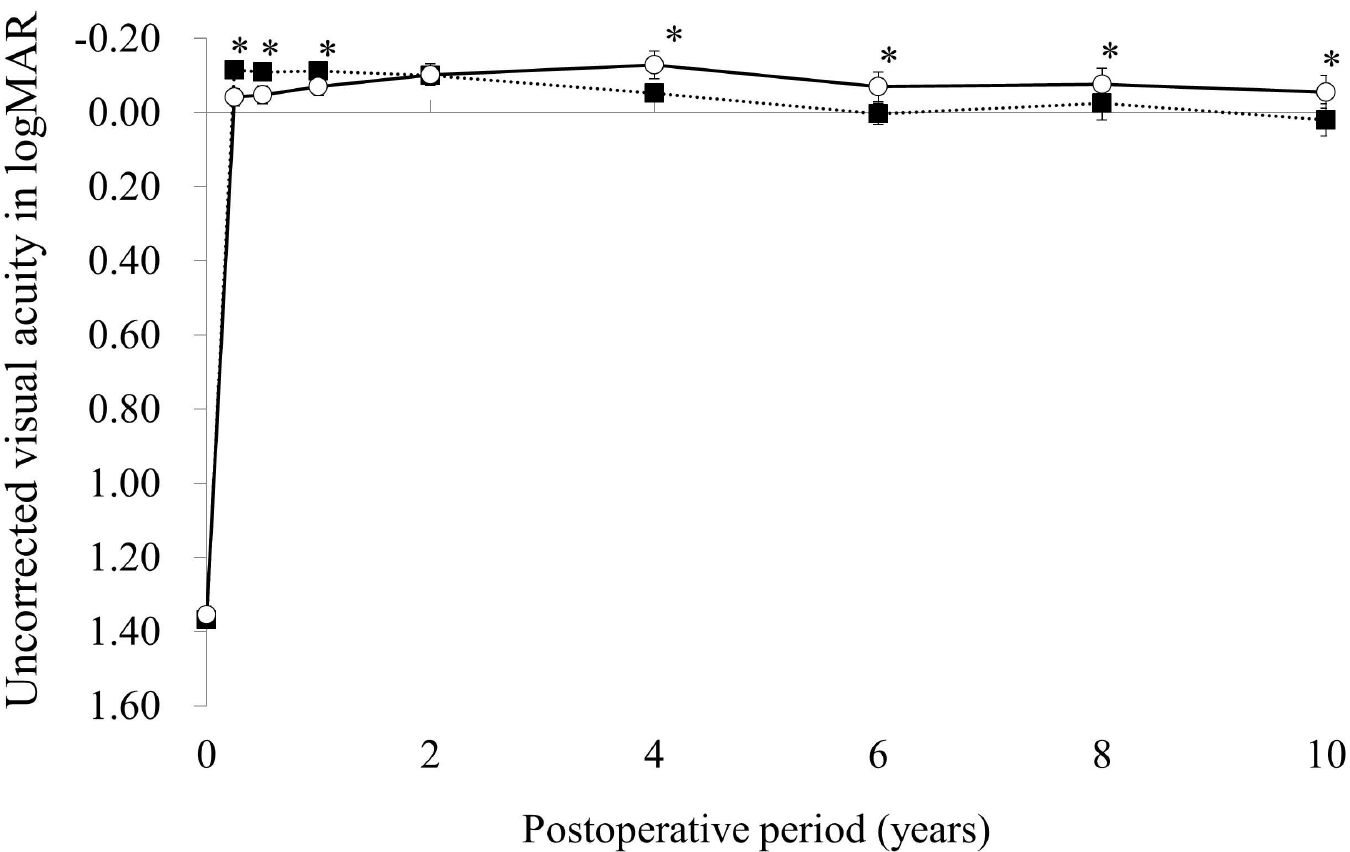
Fig 1. Time courses of the averageand 95% confidence intervals of uncorrected visual acuity in the laser in situ keratomileusis (closed square) and photorefractive keratectomy (open square) groups. * p < .05.